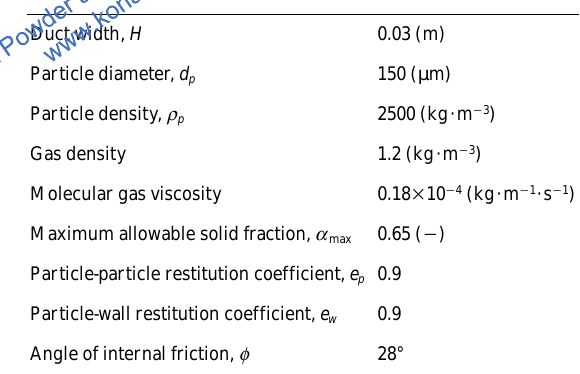
Table 3 Parameters used in the simulation test